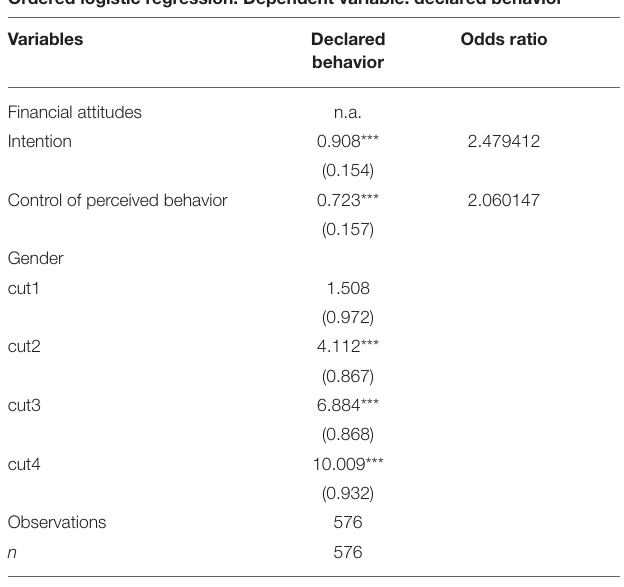
TABLE 5 | Random Forest classification model for the variable ordinal declared behavior . Random forest classification model.